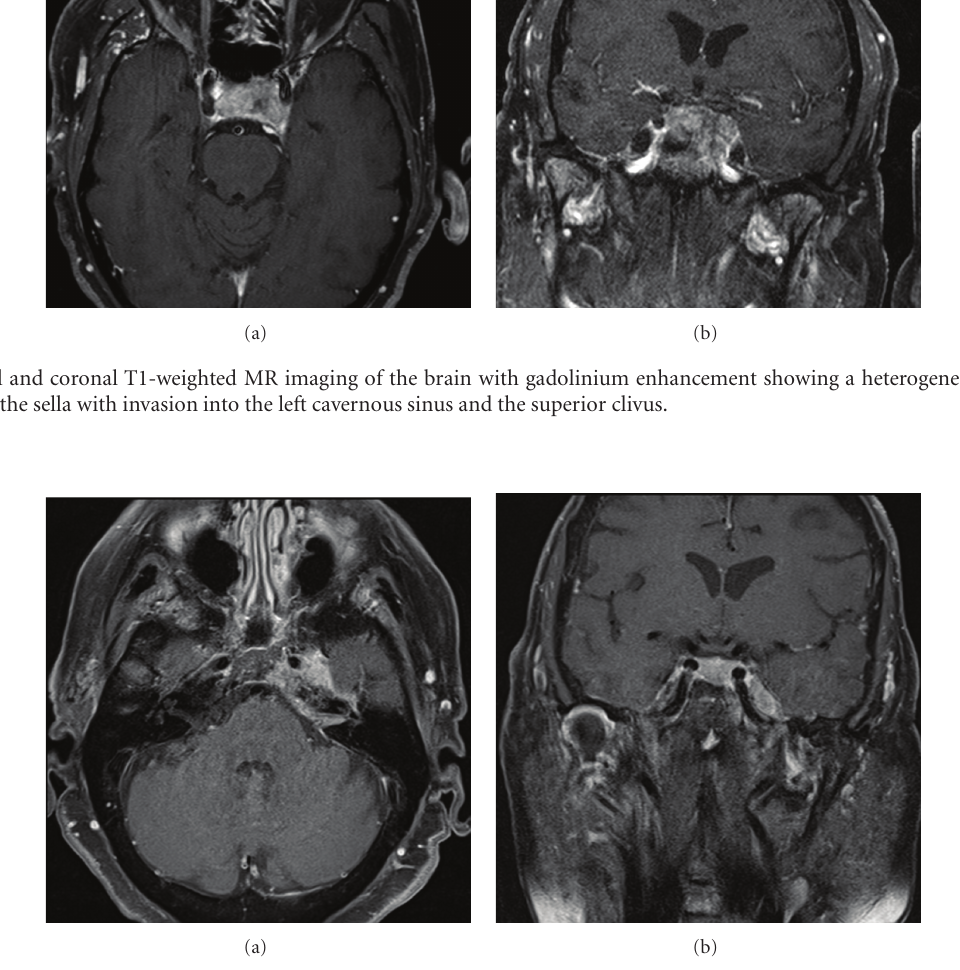
Figure 2: Axial and coronal T1-weighted MR imaging of the brain with gadolinium enhancement demonstrating a heterogeneously enhancing left petrous apex mass with extension into the adjacent middle cranial fossa and cerebellar pontine